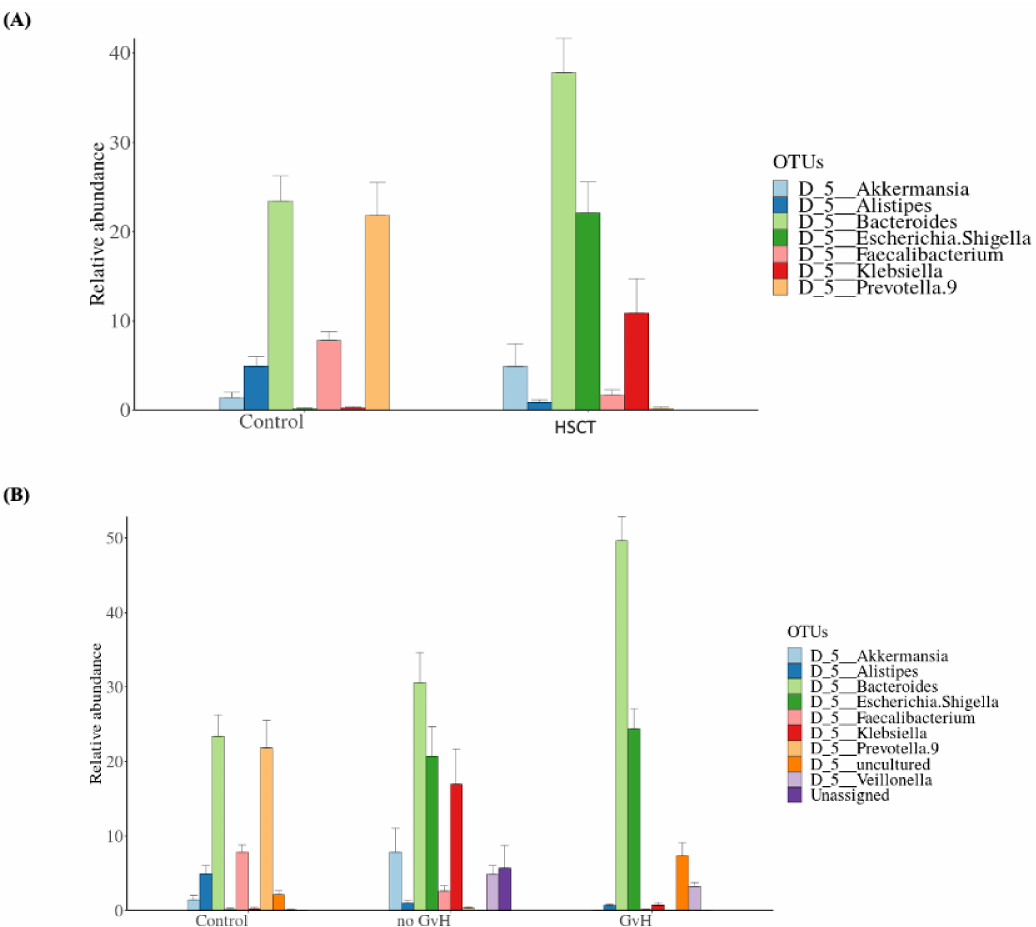
Figure 3. Comparison of the mean relative abundance of bacterial operational taxonomic units (OTUs) at the genus between ( A ) the control group ( n = 18) and allo-HSCT recipients ( n = 15), and ( B ) control subjects; patients suffering and non-suffering from graft-versus-host disease ( n = 4 and n = 11,